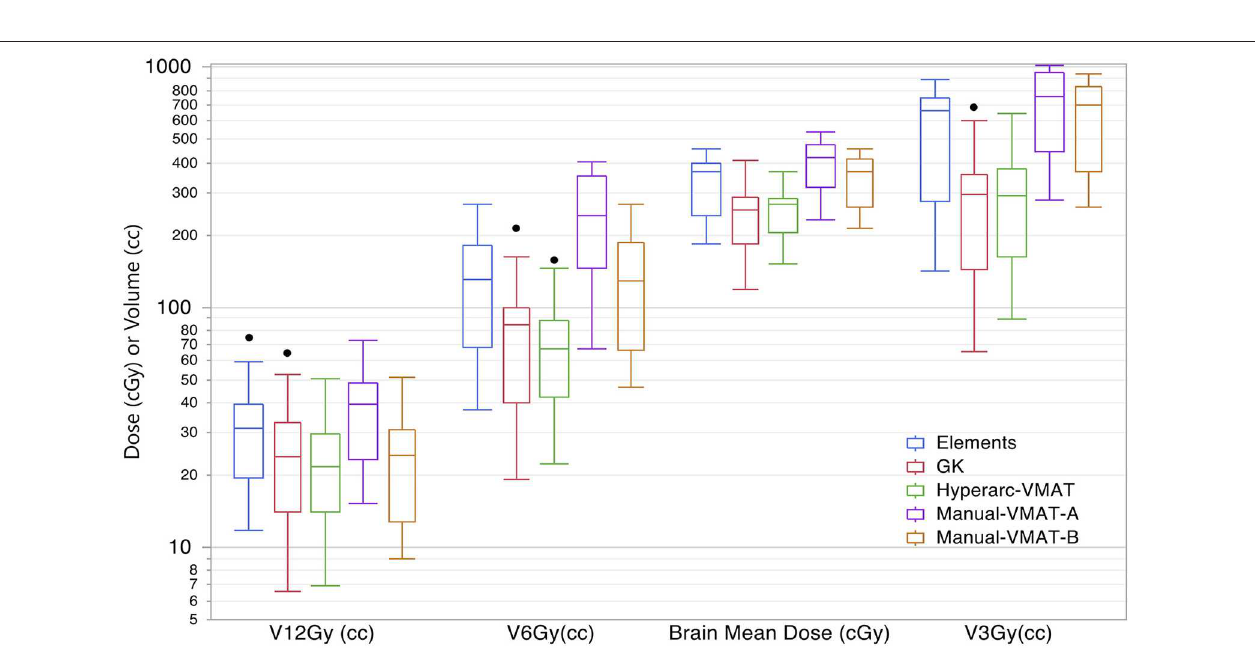
Frontiers in Oncology |